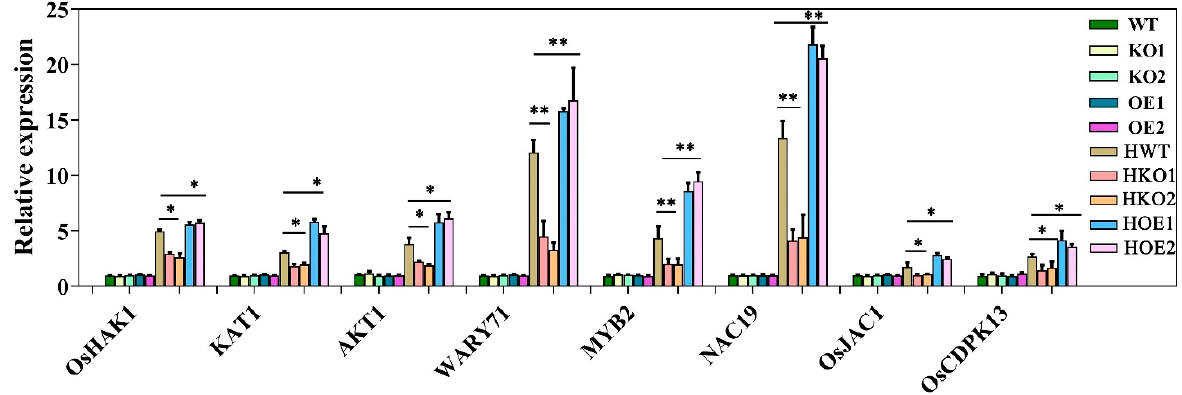
Figure 12. OsJRL40 regulates the expression of salt stress signaling-related genes under salt stress. WT, KO1, KO2, OE1, and OE2 seedlings at the three-leaf stage were treated with 100 mM NaCl for 8 h. After RNA extraction and reverse transcription, RT-qPCR was performed. Osactin was used as the internal control gene. Data represent the mean ± SD of three independent replicates. Asterisks indicate statistically significant differences (* p < 0.05, ** p < 0.01).